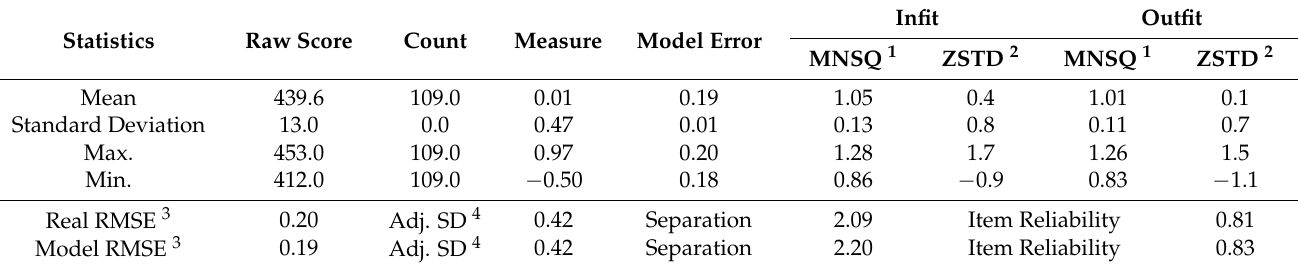
Table 7. Statistical summary of items (self-efficacy).